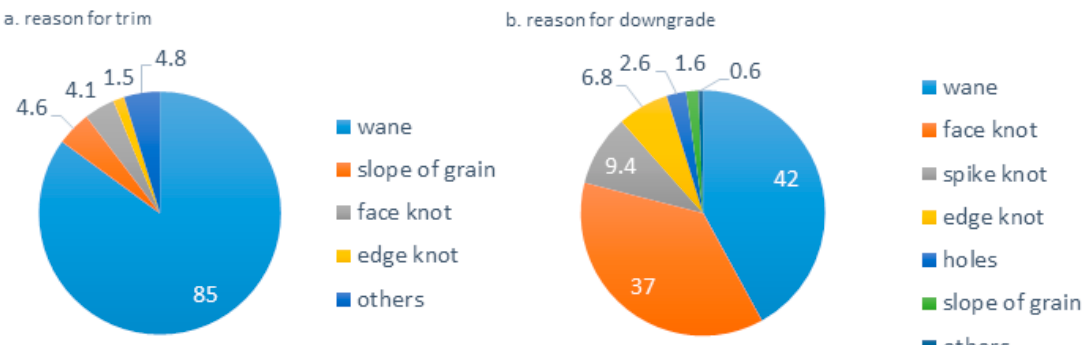
Figure 2. Percent of end-trim of lumber ( a ) and visual grade downgrade factors ( b ) for all lumber combined.